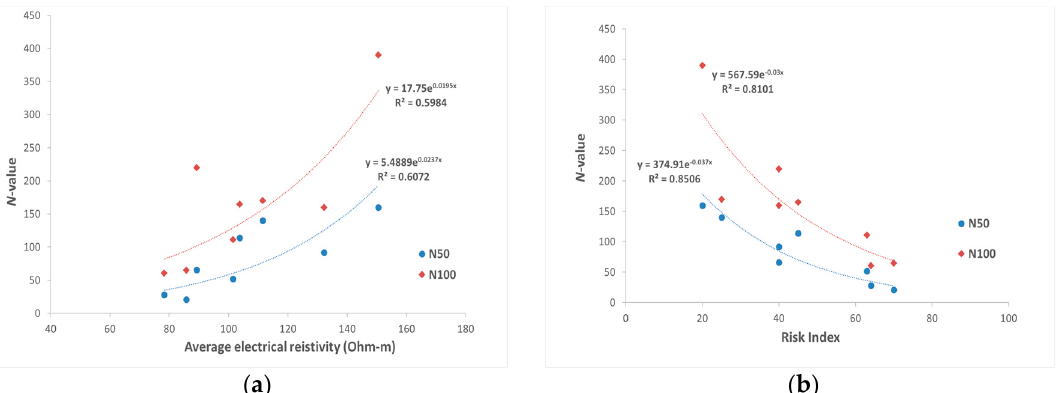
Figure 9. Relationship between field measurements; ( a ) N -value versus average electrical resistivity and ( b ) N -value versus risk index.